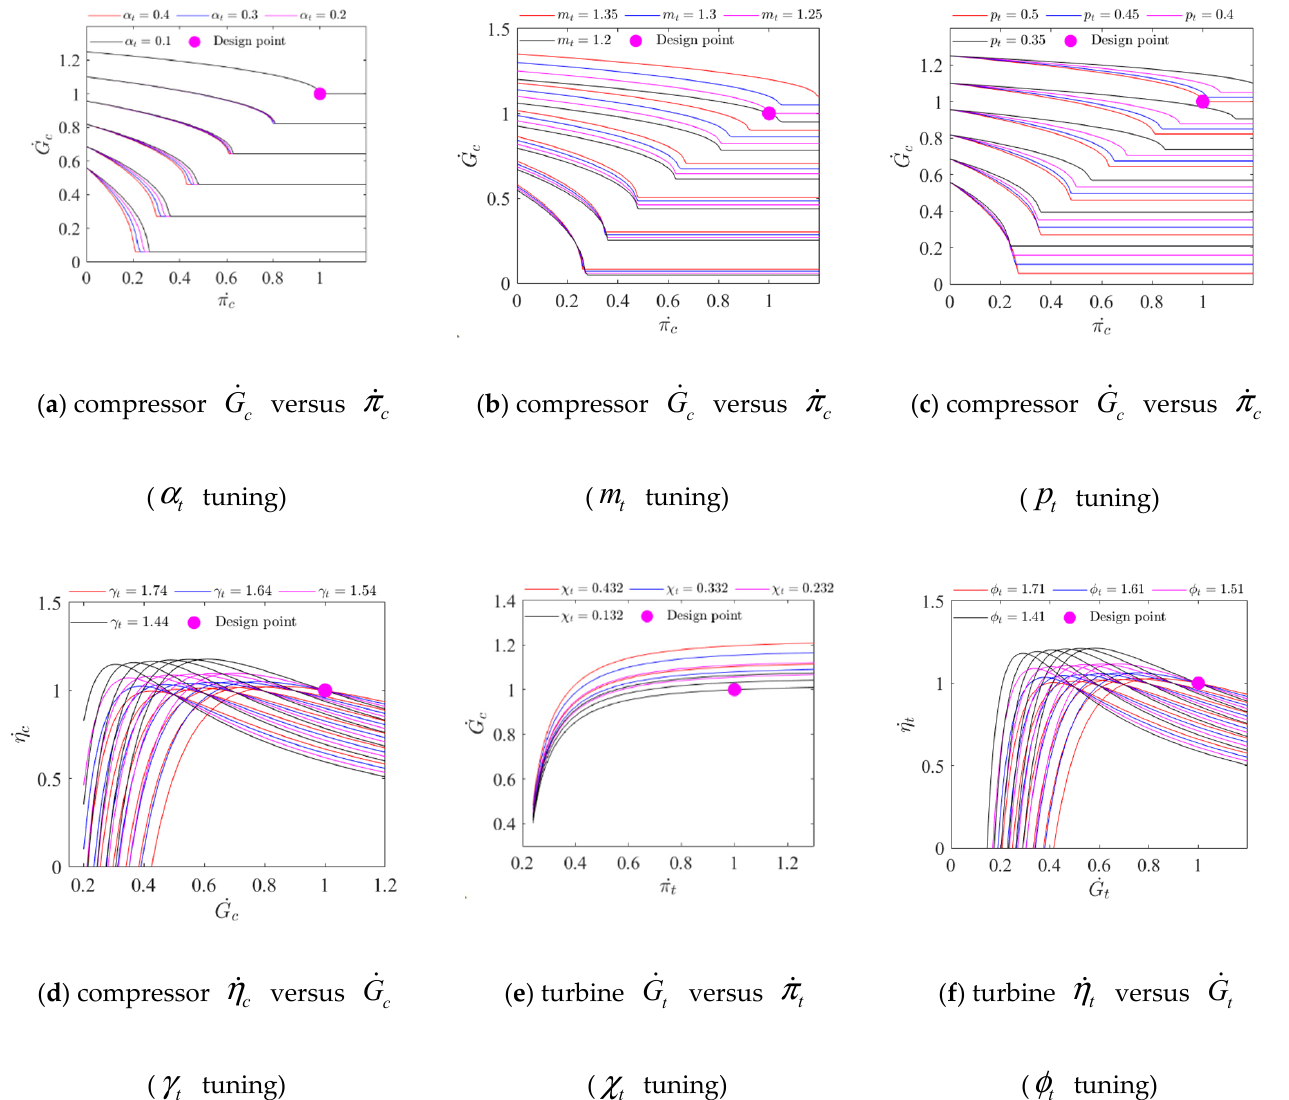
Figure 1. The effects of the tuning factors on the shape of the component maps.